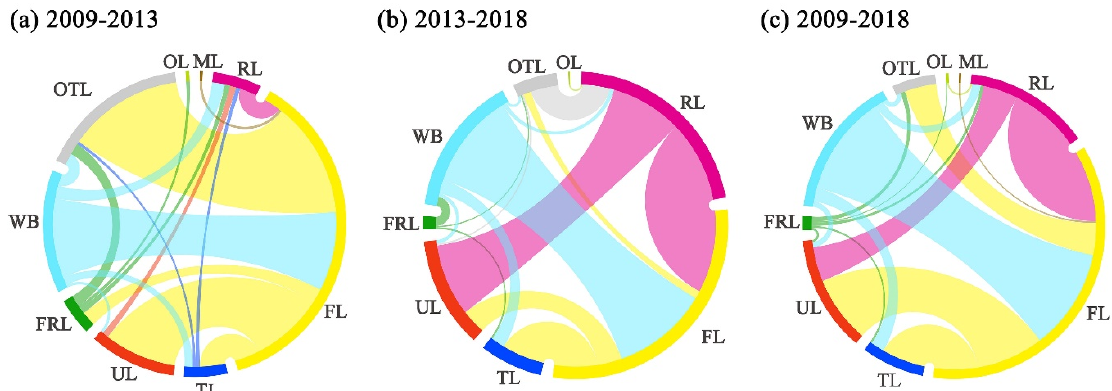
Figure 4. Land use conversion flows in Sihong during 2009–2013 ( a ), 2013–2018 ( b ), and 2009–2018 ( c ). The sizes of the lines are proportional in width to the contributions of each land-use type to the change.